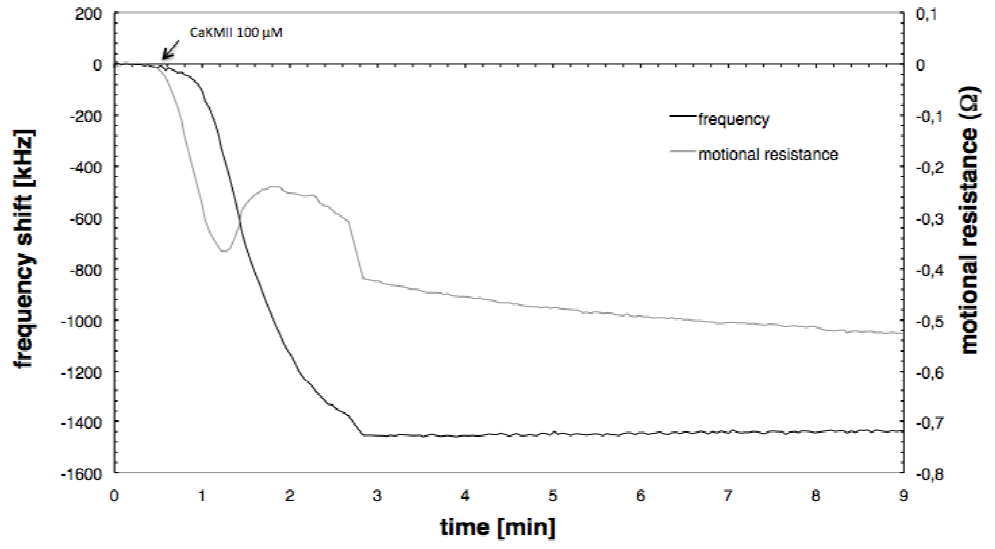
Figure 5. Frequency response and motional resistance change of CaMKII peptide binding to the Ca 2+ /calmodulin